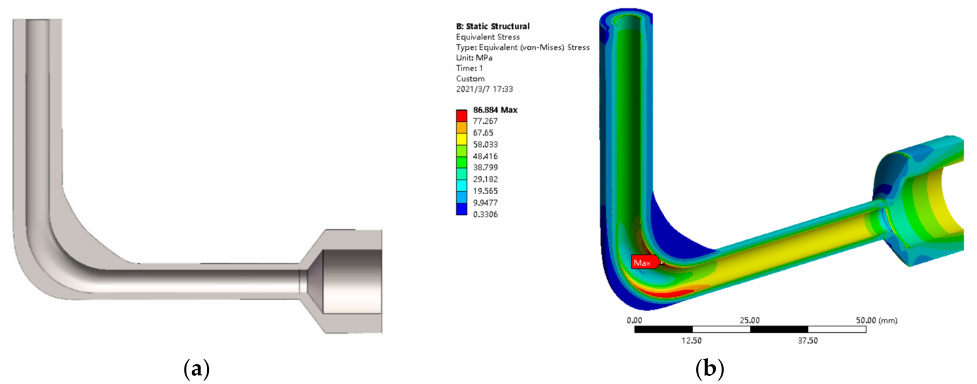
Figure 11. Design optimization of the solid domain: ( a ) cross-sectional view of the CAD model, ( b ) stress distribution.